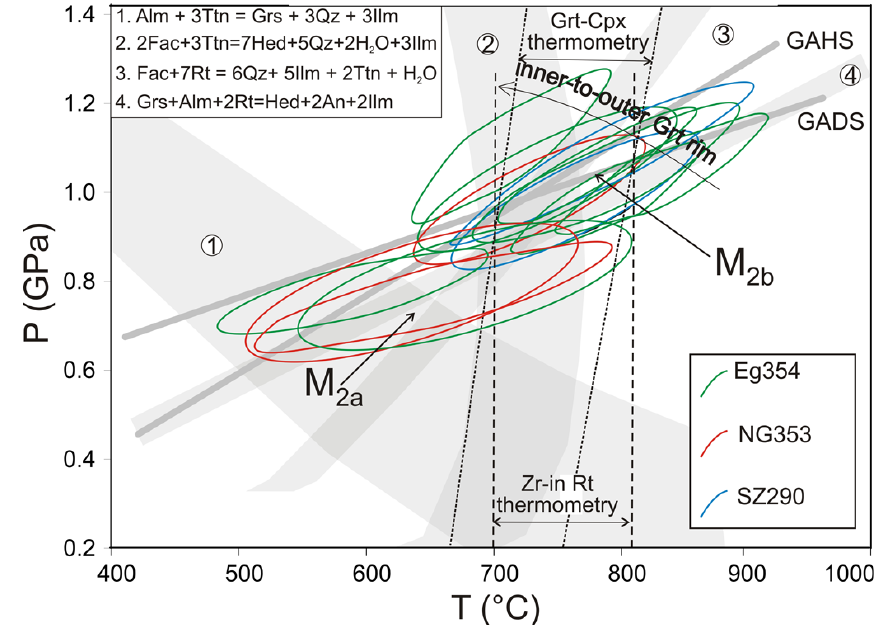
Fig. 10. Results from conventional thermobarometry, compared with those obtained from the THERMOCALC software in the average P - T calculation mode. The latter results are shown as best fit ellipses, with error quoted at 1 σ level. The grey areas show the P - T fields calculated with the THERMOCALC software that pertain to the single reactions (numbered in the inset) that involve the Ti-bearing phases relevant for the main rock forming mineral assemblages (mineral abbreviations follow Whitney and Evans, 2010). See text for further details.